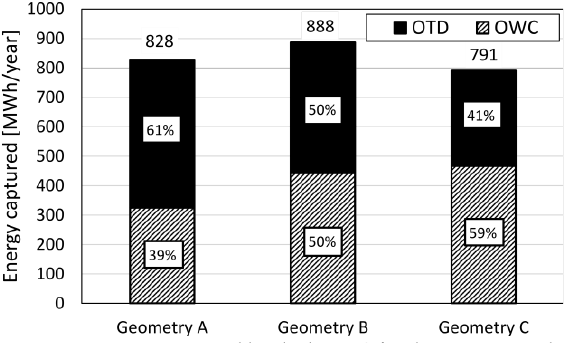
Fig. 11. Energy captured by the h-WEC for the geometry selection tests and each component’s contribution.